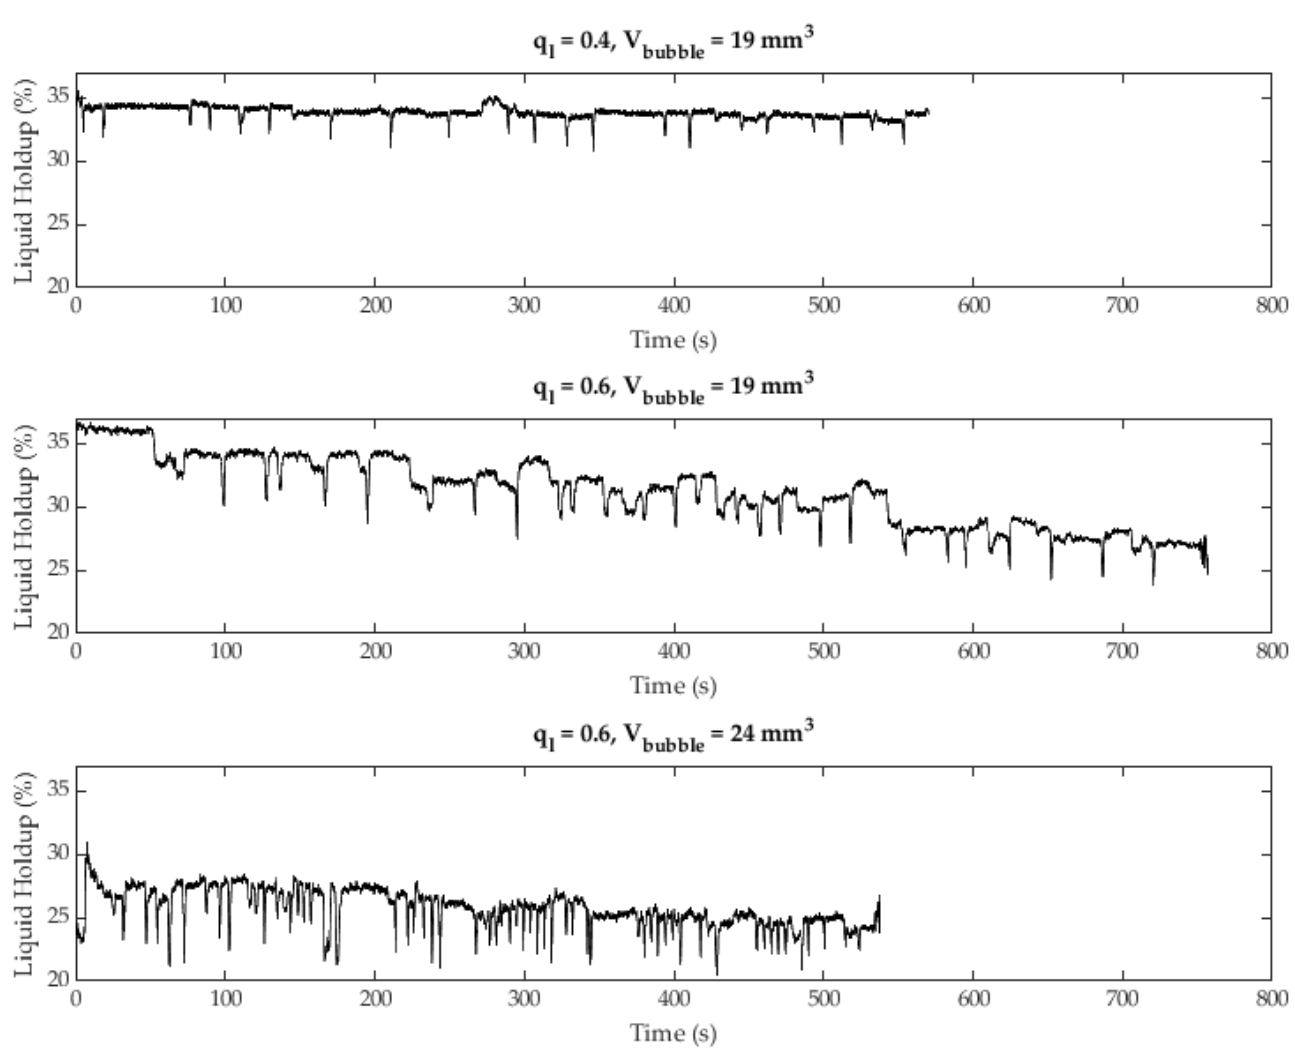
Figure 7. The change in liquid holdup over the time in the 0.6 mm channel under three flow condi- tions.